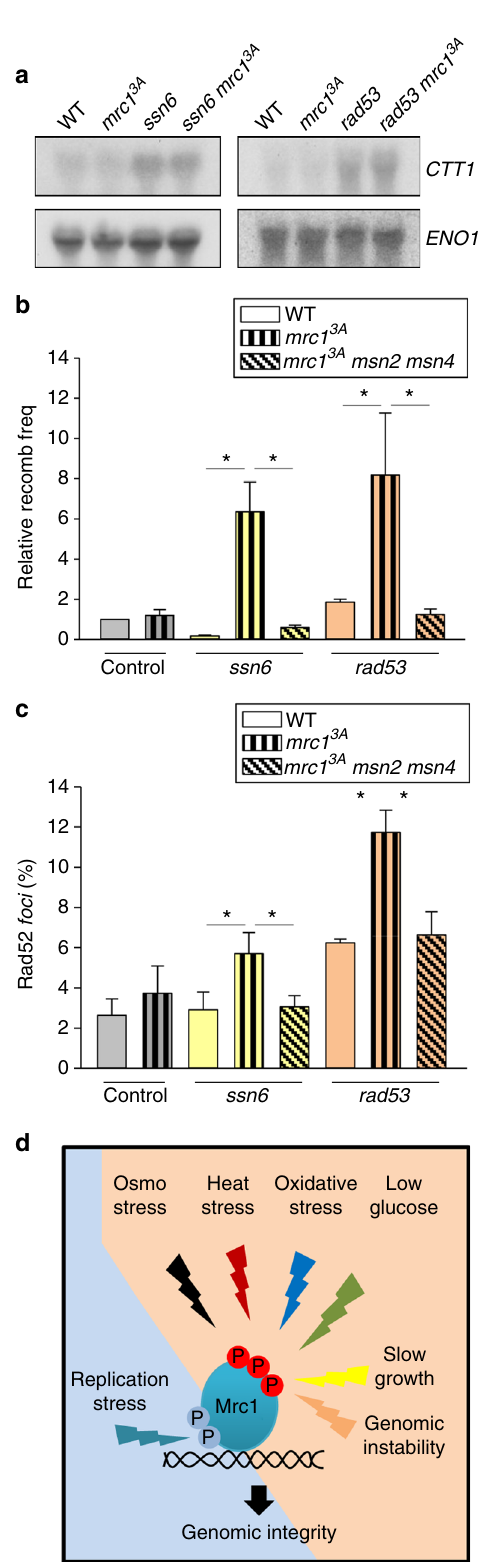
Fig. 7 Mrc1 prevents TAR upon slow growth and genomic instability.